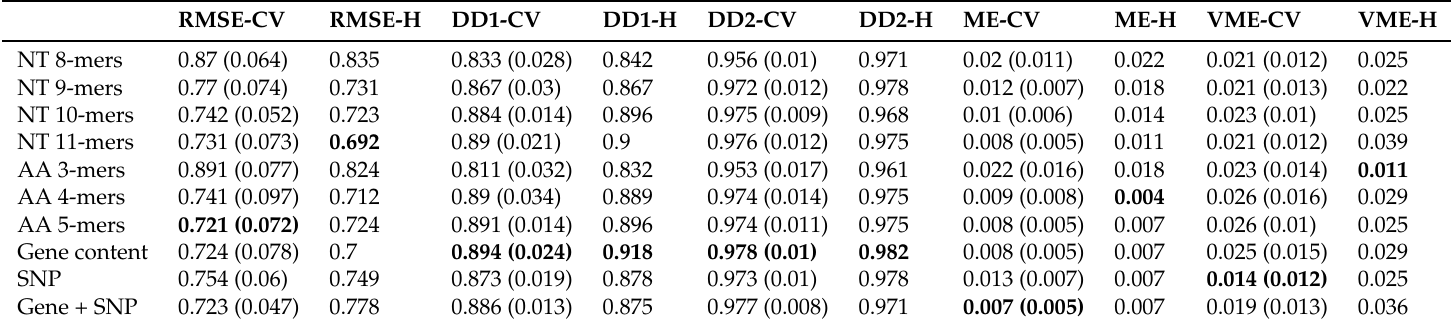
Table A61. S. enterica –streptomycin.